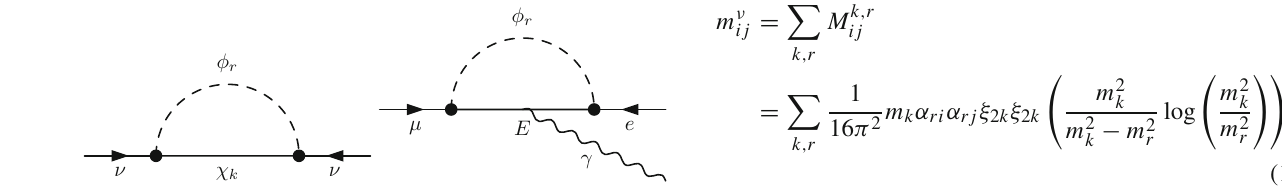
Fig. 1 Left: the diagram responsible for neutrino mass generation. Right: one of the diagrams contributing to μ → e